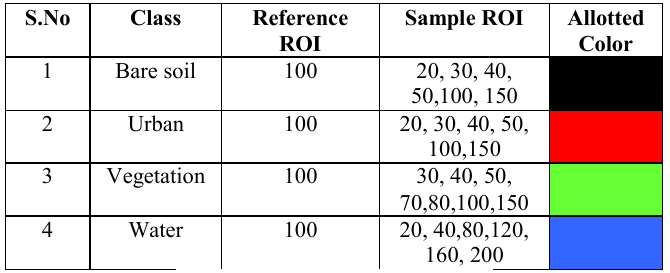
Table 1 Ground truth survey points